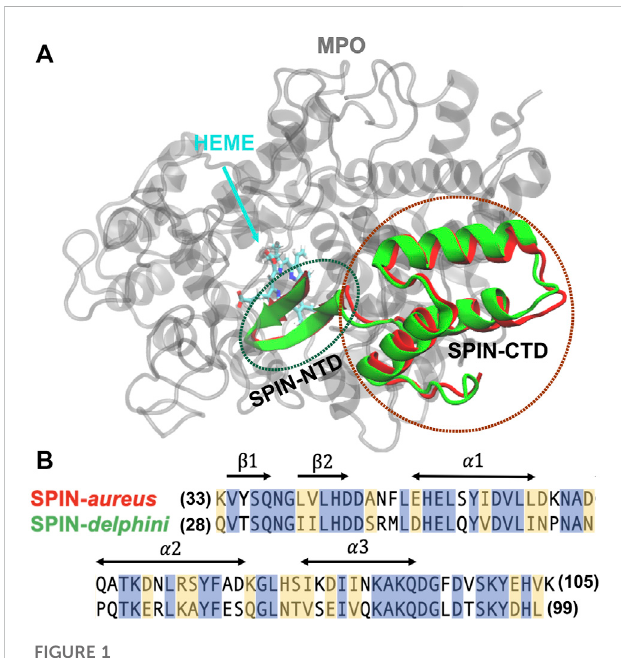
FIGURE 1 (A) Overlay of structures SPIN- aureus and SPIN- delphini in complex with human MPO. The structures were taken from PDB 5UZU and 6BMT for SPIN- aureus and SPIN- delphini , respectively. MPO is colored grey and SPIN- aureus and SPIN- delphini are colored red and green, respectively. Heme was shown in sticks. (B) NTD sequences of two SPIN homologs with conserved residues are highlighted in blue and similar residues in yellow. The sequence alignment is calculated usingBLAST(Parketal.,2012)thatshows53%identityand80%similarity. The secondary structures in the bound state are marked with